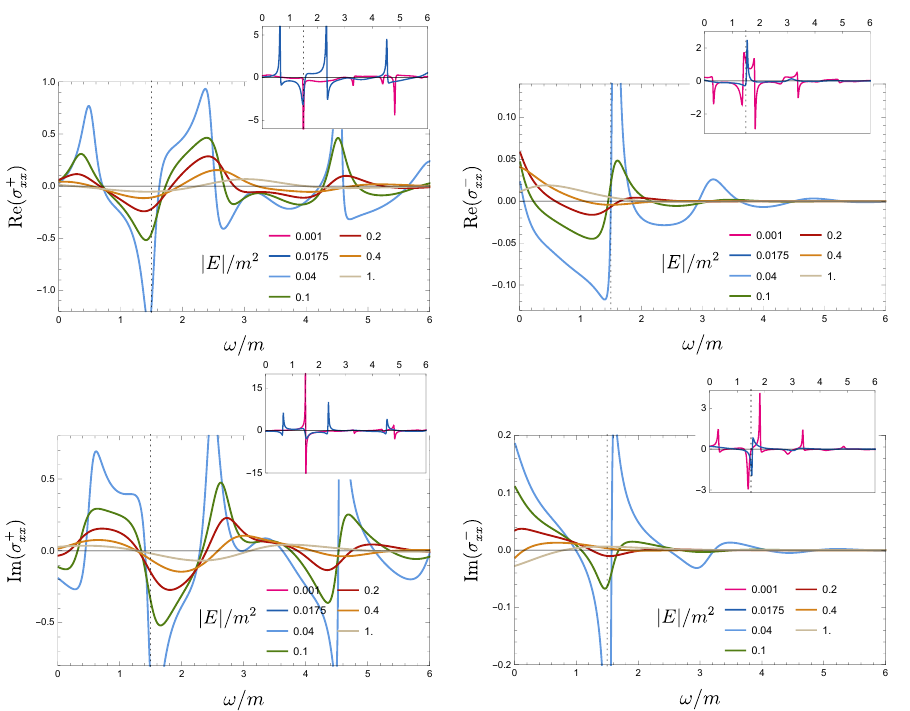
Figure 17 . AC Conductivities for (cid:12)xed value of (cid:10) =m = 1 : 496 and di(cid:11)erent values of j E j =m 2 . They correspond to the vertically aligned dots in (cid:12)gure 12 with the same color code. In the insets, the curves for low values of j E j =m 2 ! 0 deep into the critical wedge, where they develop peak resonances. The value !=m ! (cid:10) =m = 1 : 496 is signalled with a dashed vertical line.